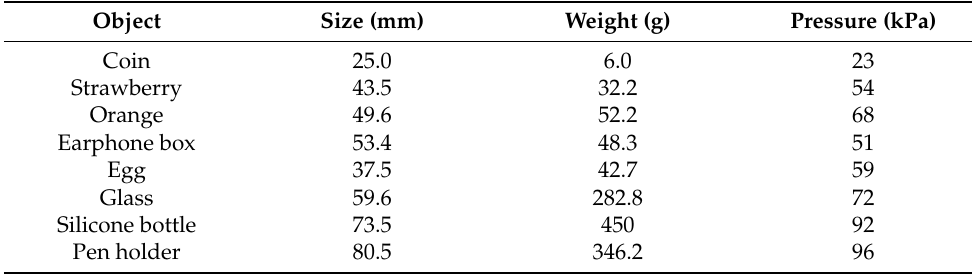
Figure 14. Clipping diagram of some test objects. Table 3. Objects used in gripping